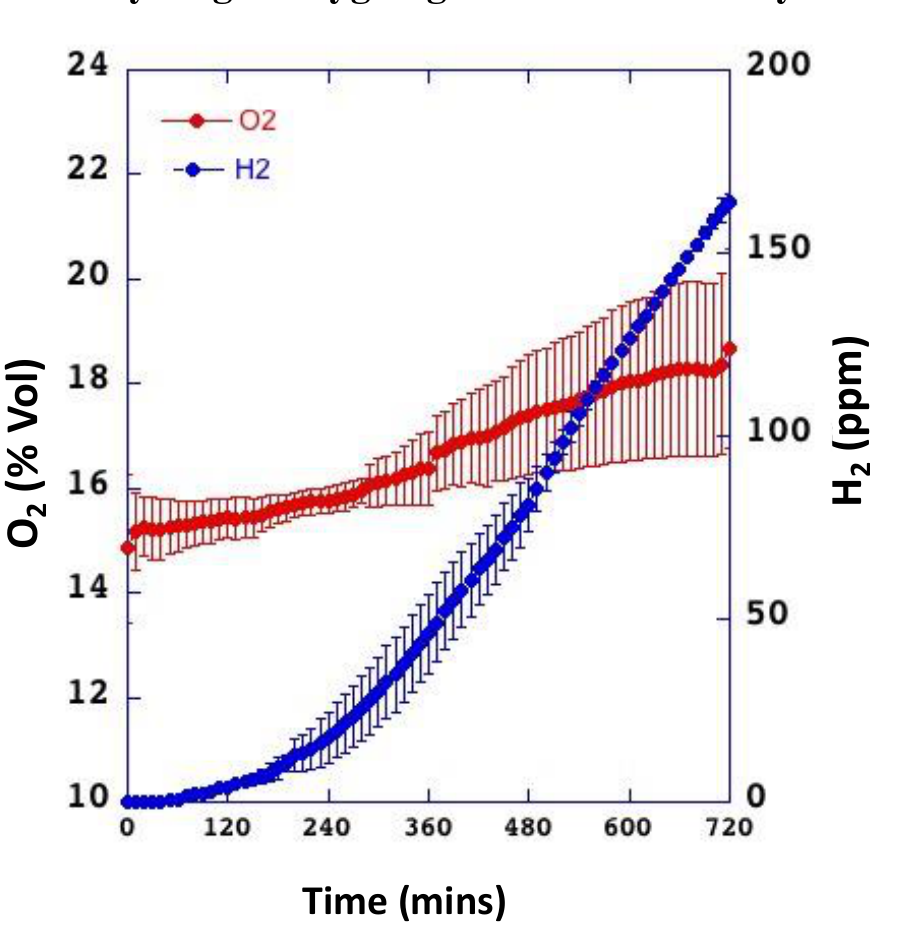
Figure 3. Hydrogen/oxygen-generation efficiency of the water-activated HOGP. H + and O 2 concen- trations were measured in sealed and vacuum containers as a function of time starting immediately after adding water to the powder and sealing the vessel. The stable H + and O 2 concentration was 0.23 ppm/min and the oxygen release rate was 68.3 ppm/min over a 12-h period. 3.2. Wearing the Patch Significantly Increases Blood H + and O 2 Levels In Vivo Blood H + peaked at 2 h after application of the patch, and progressively decreased to ~1.05-fold (5% difference) until the end of study at 48 h (Figure 4A; red line), whereas the blood pH values slightly changed over time (Figure 4A; blue line). As shown in Figure 4B, the concretions of bicarbonate (HCO 3 − ) and total carbon dioxide (tCO 2 ) exhibited similar patterns as the levels of blood H + . The partial pressure of oxygen (pO 2 ) started to increase at 2 h after application of the patch, reached pO 2 -max at post 6 h ( p < 0.05 compared to baseline), and then declined between 24 and 48 h (Figure 5A; red line). The partial pressure of oxygen (pCO 2 ; relative to blood H + ) significantly increased at 2 h after application of the patch ( p < 0.05 compared to baseline) and then slightly reduced and eventually remained at ~1.05-fold (5% difference) up to the end of the 48-h study period (Figure 5A; blue line). The mean plasma concen- tration versus time profiles of the oxygen content (O 2(ct) ) and oxygen saturation (SO 2(SAT) ) showed similar patterns as the levels of pO 2 after application of the transdermal patch (Figure 5B). Moreover, hemoglobin-oxygen affinity (p50 (c) ) and the alveolar-arterial oxygen gradient (aDO 2 ) also increased at 2 h after application of the patch ( p < 0.05 compared to baseline) and then gradually returned to baseline (Figure